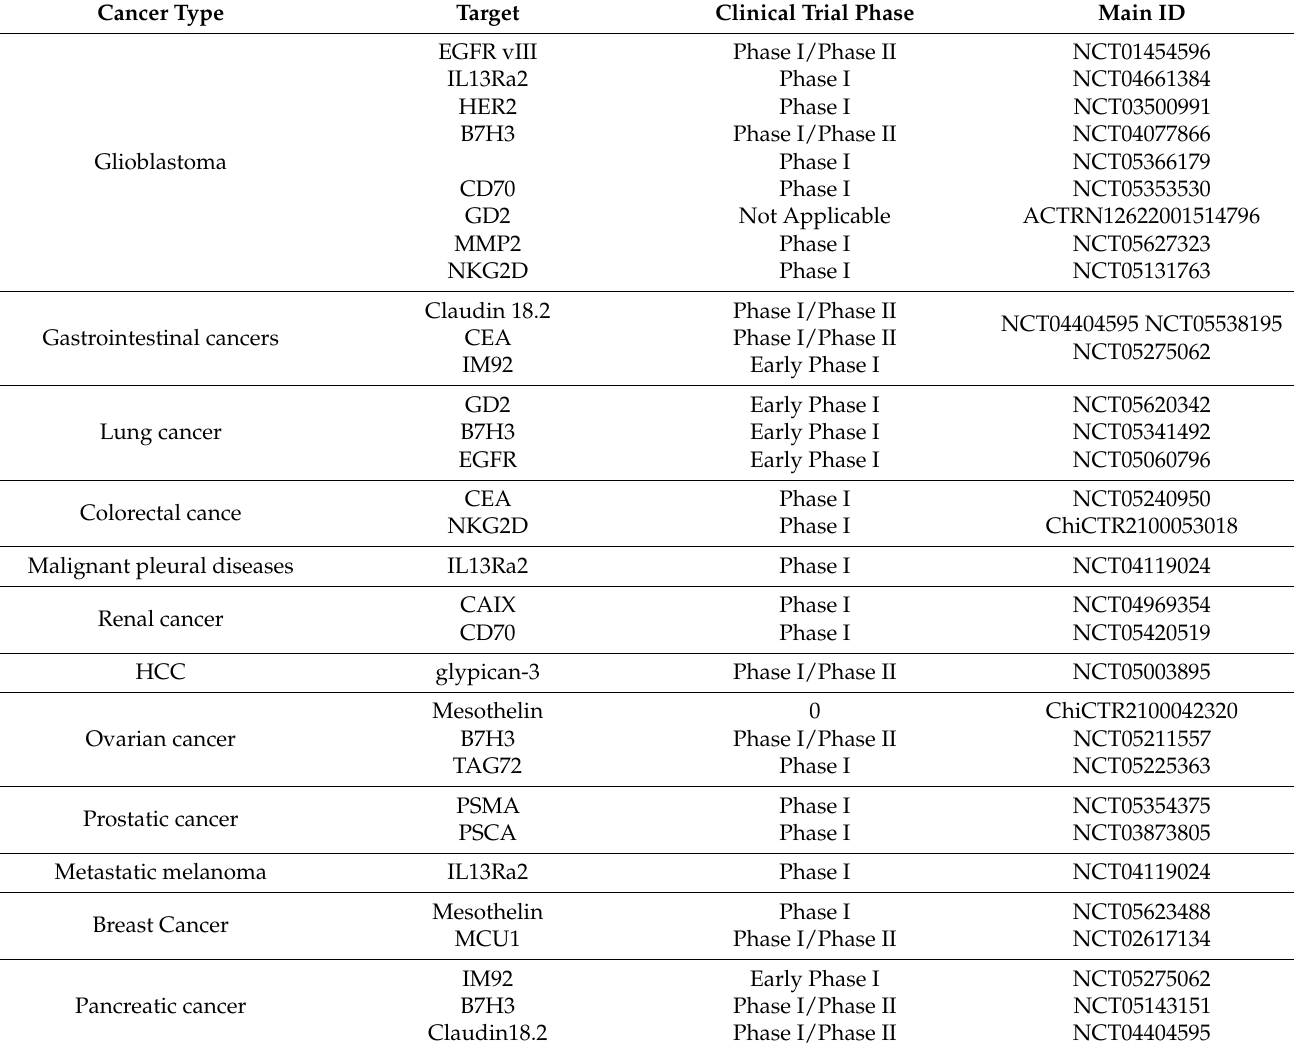
Table 1. Published clinical trials of CAR-T for solid tumors and related